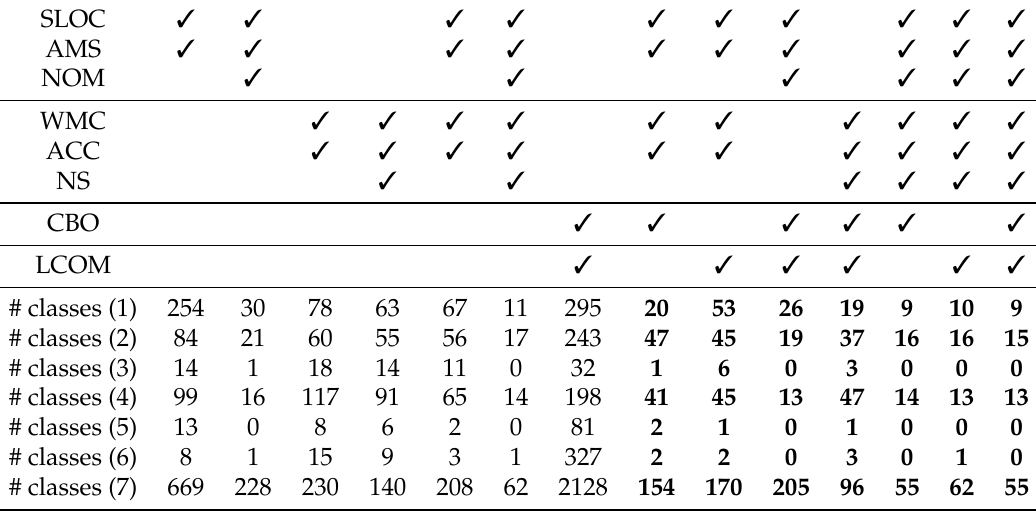
Table 6. Number of identified classes within Alfresco Repository (1); JasperReports Library (2); JHotDraw (3); ApacheTomcat (4); Jenkins (5); Gradle (6) and Liferay Portal (7) using a combination of software metrics.